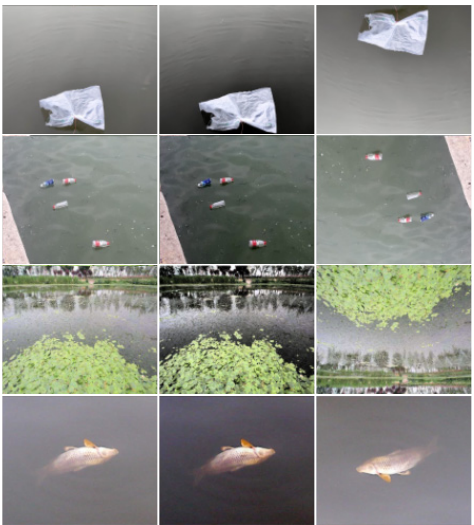
Figure 13. Dataset types and expansion effects. Left to right: original images, increased-contrast images, and mirror images. Table 2. Float dataset.